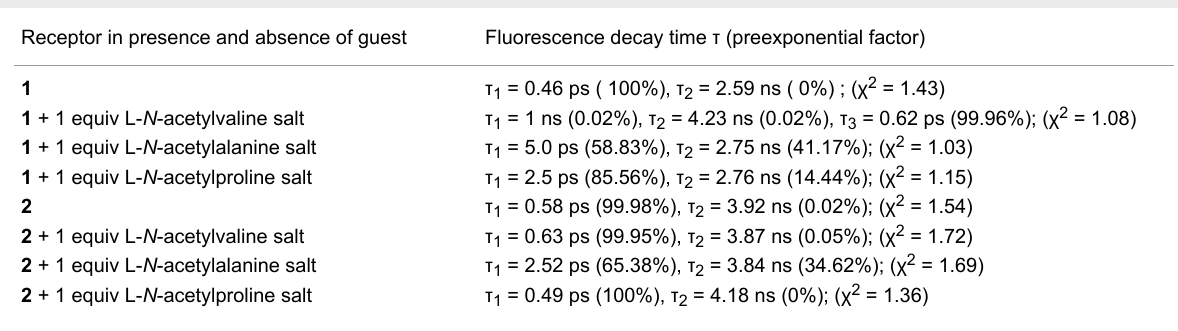
Table 1: Fluorescence decay times ( τ ), and preexponential factors for 1 and 2 in CH 3 CN. Receptor in presence and absence of guest